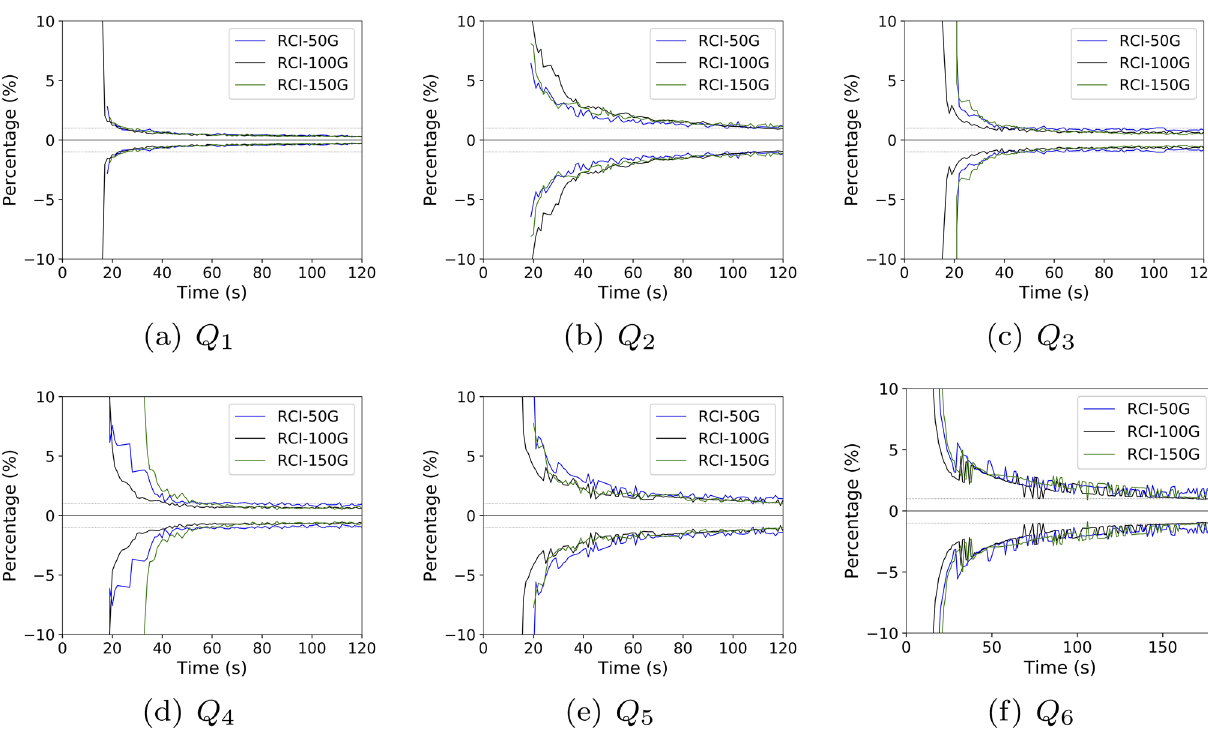
Fig. 7 The convergence of RCI for Q 1 – Q 6 on different data sizes